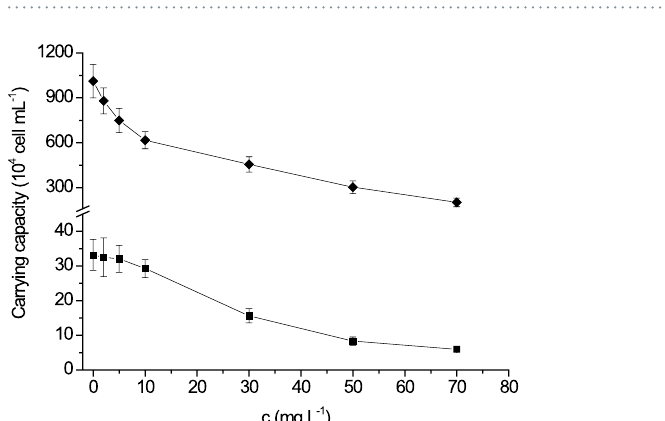
Figure 1. Changes of carrying capacity and rotifer density with Ciprofloxacin hydrochloride concentration in single-species toxicity tests (the dots displaying were mean values and the error bars stood for standard ◆ deviations; ■ : P. subcordiformis ; : I. galbana ; ▲ : B. plicatilis ).